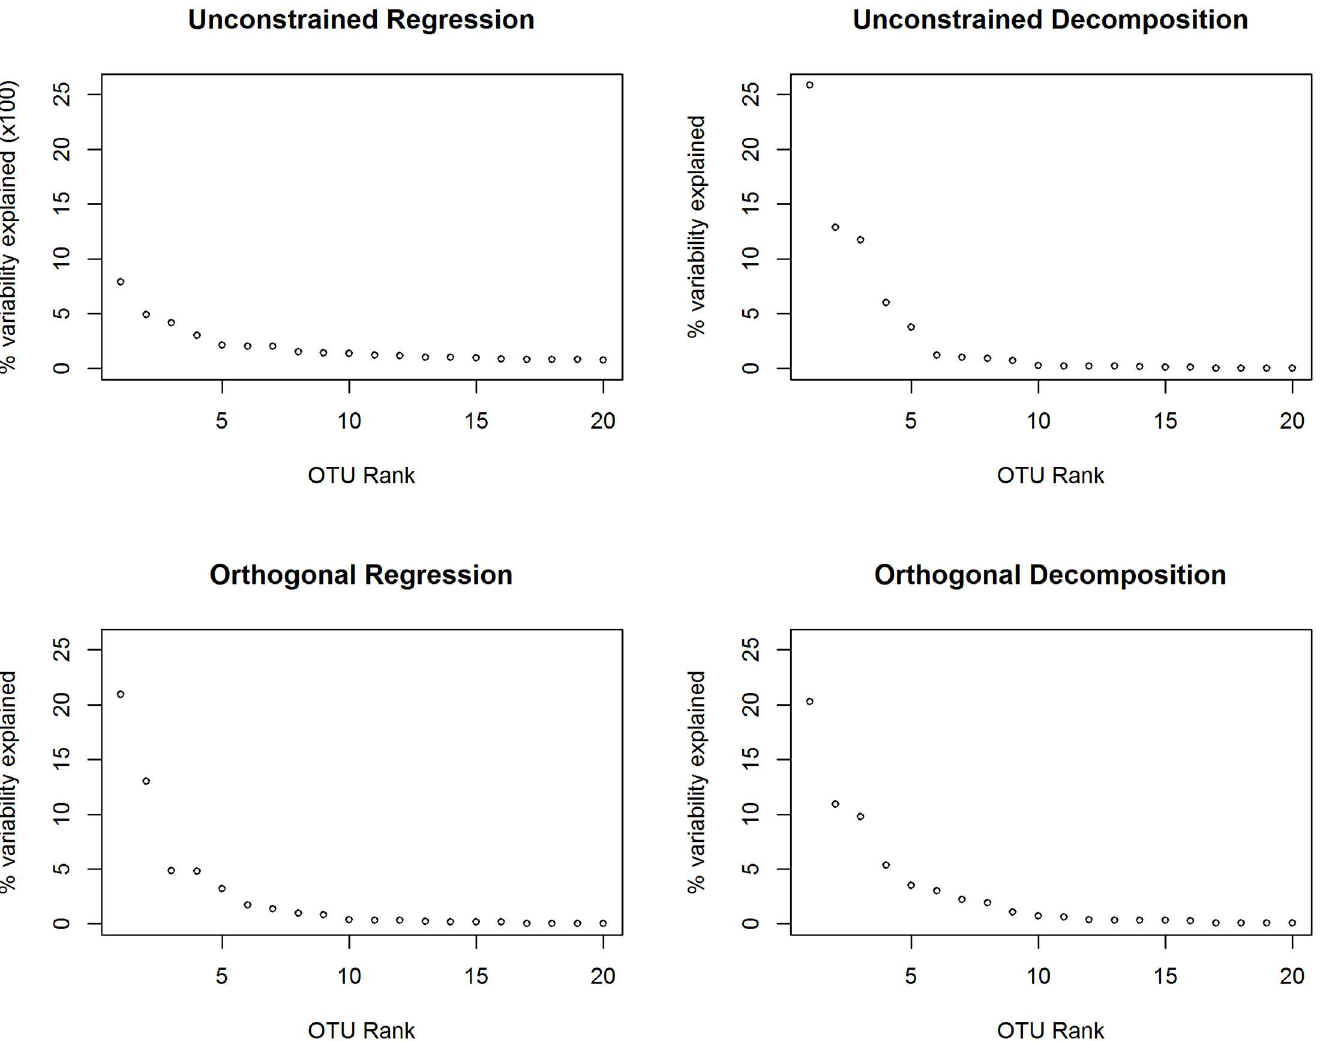
Fig 2. Screeplots for varianceexplained by each OTU. For each method, the contribution of the 20 (of 271) OTUs having the largest contributions are plotted. Note the change of scale for unconstrained regression.